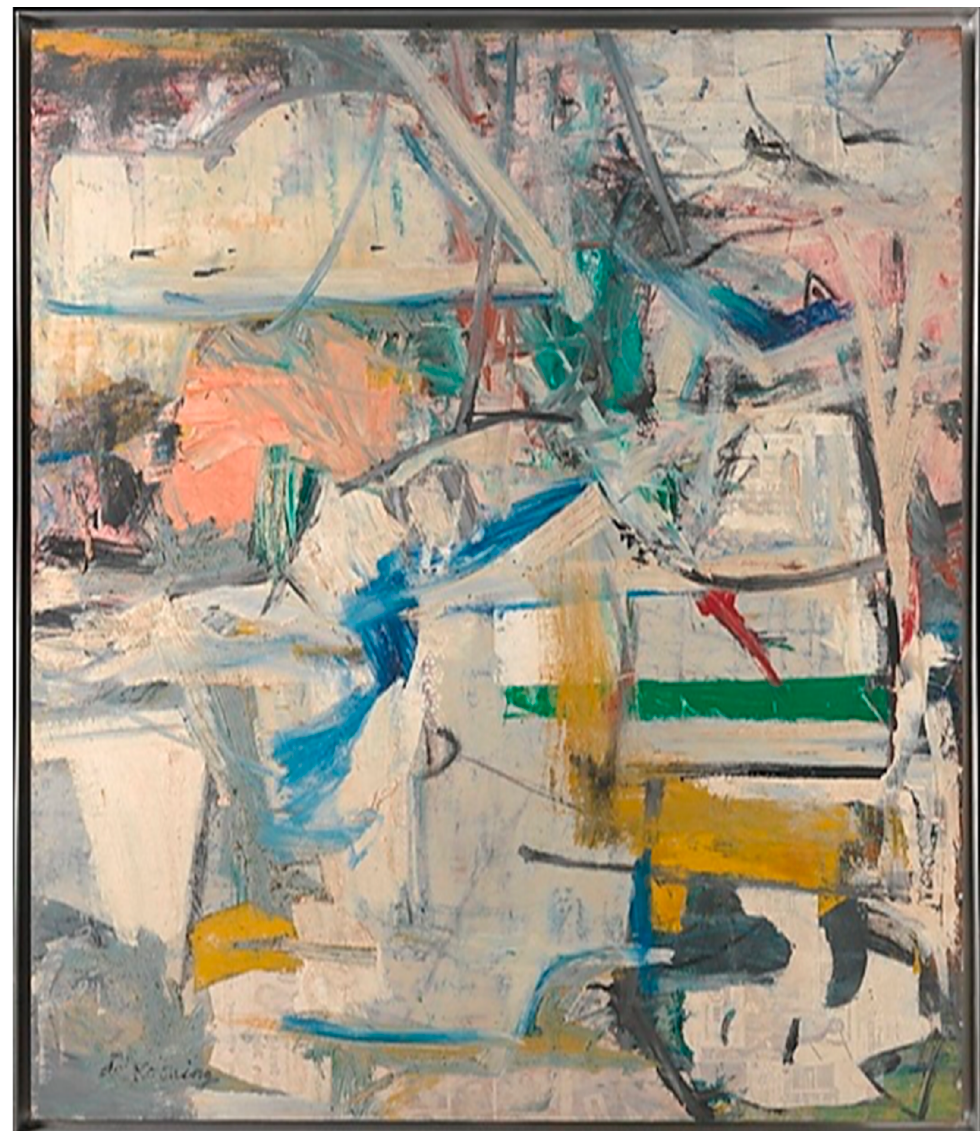
Figure 1. Willem de Kooning, Easter Monday , 1955–56, oil and newspaper transfer on canvas, 96 × 74 inches, The Metropolitan Museum of Art, New York, Rogers Fund, 1956 (56.205.2). All artworks by Willem de Kooning © 2023 The Willem de Kooning Foundation/Artists Rights Society (ARS), New York.